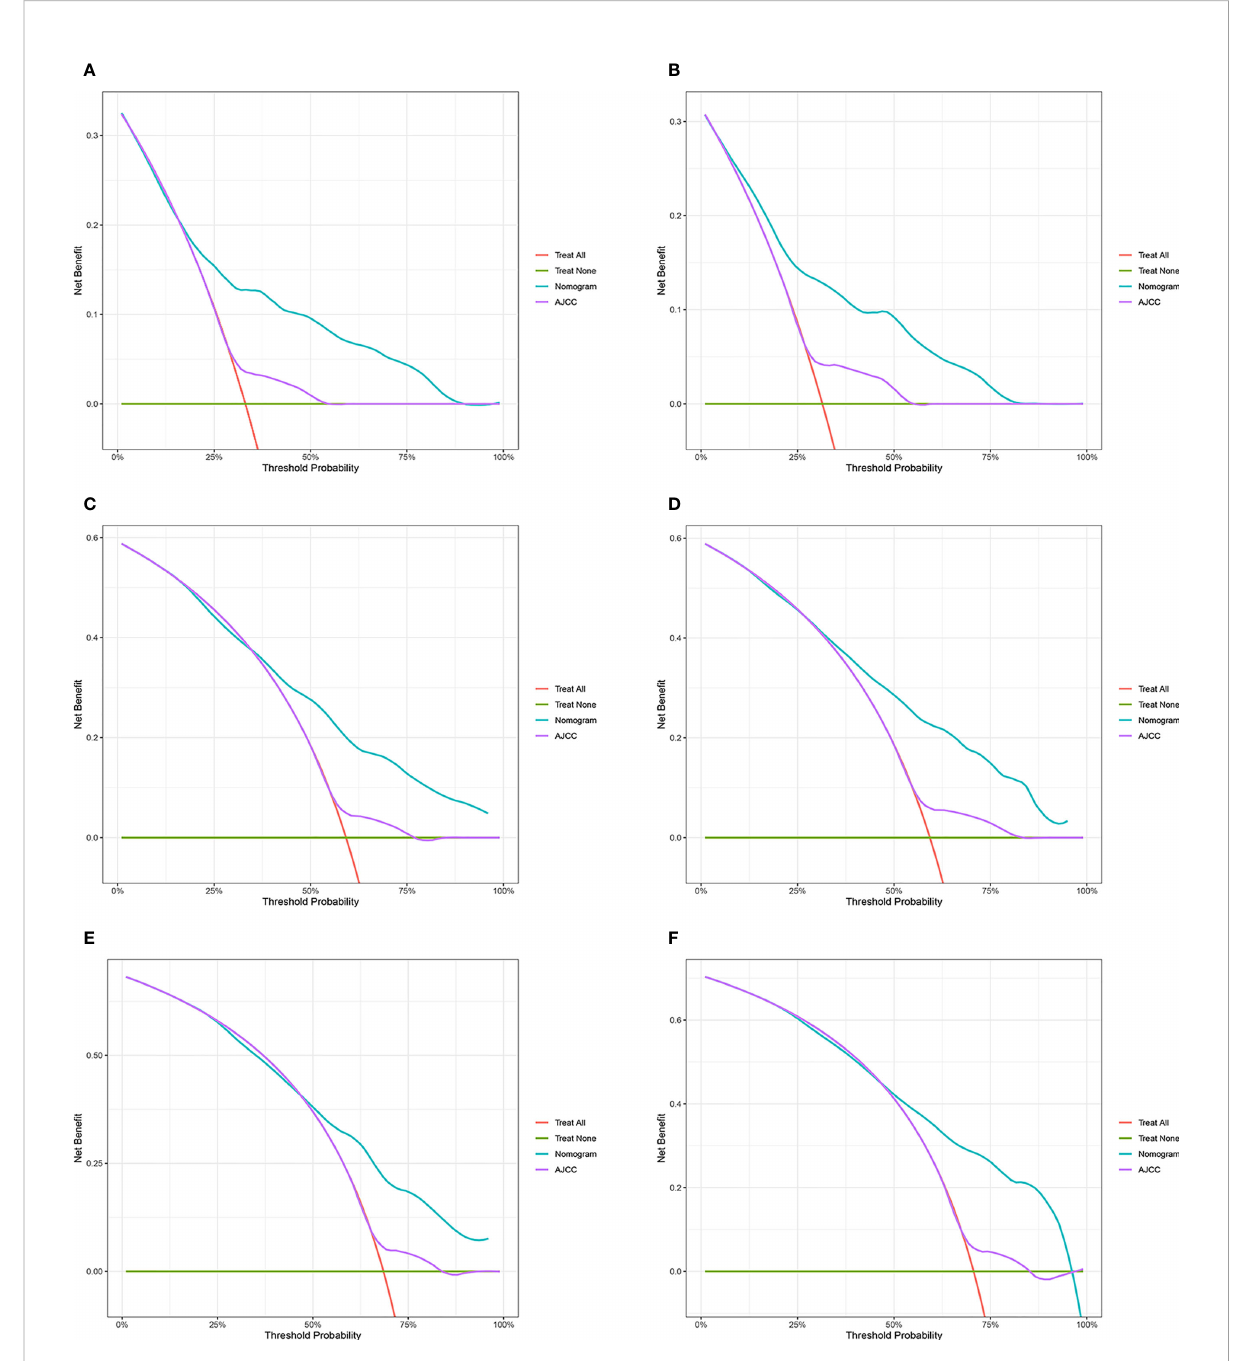
FIGURE 4 Decision curve analysis of the nomogram and AJCC tumor staging for the cancer-speci fi c survival prediction of HCC patients with MVI. (A, C, E) 1-, 3- and 5-year cancer-speci fi c survival bene fi ts based on the training cohorts. (B, D, F) 1-, 3- and 5-year cancer-speci fi c survival bene fi ts based on the validation cohort. HCC, hepatocellular carcinoma; MVI, microvascular